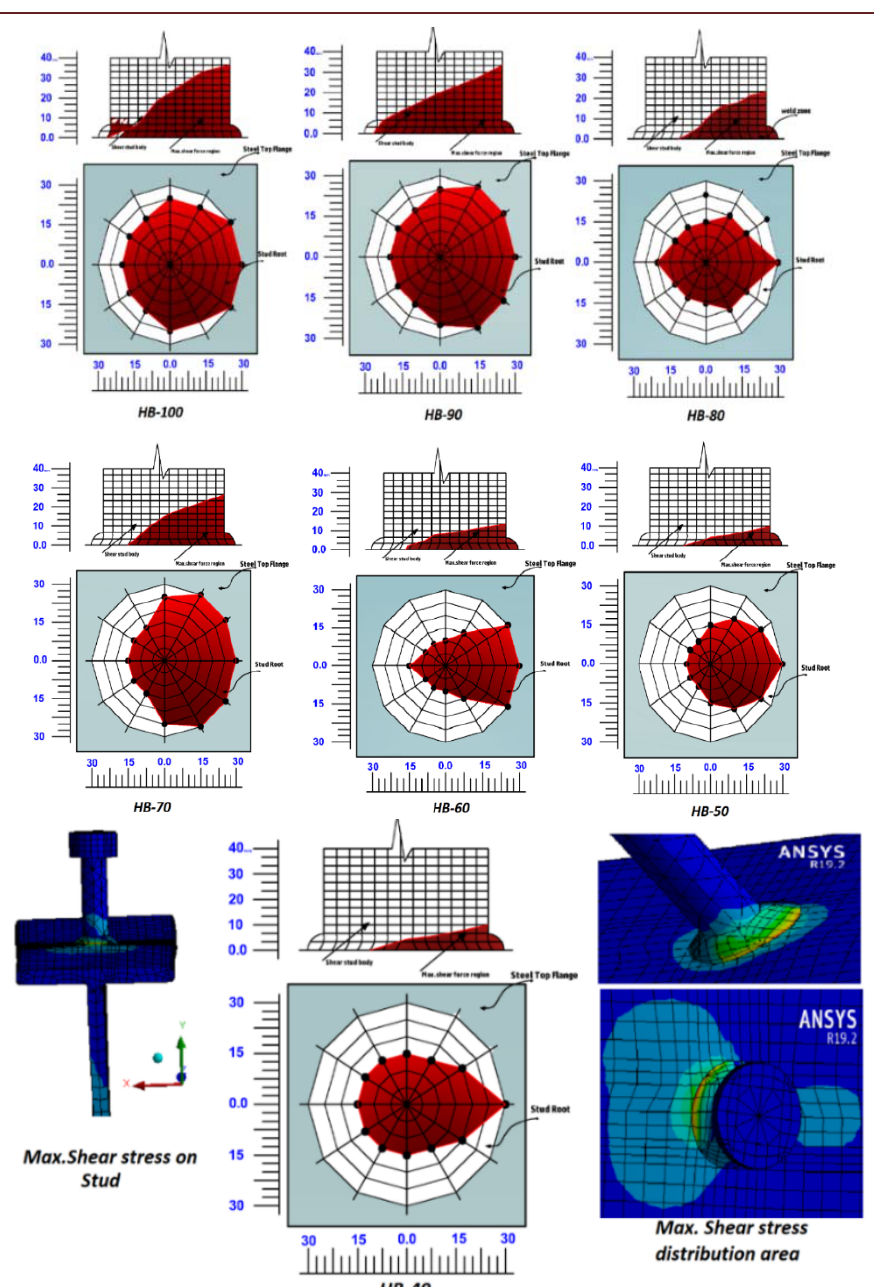
Figure 5: The maximum principal shear stress distribution around stud